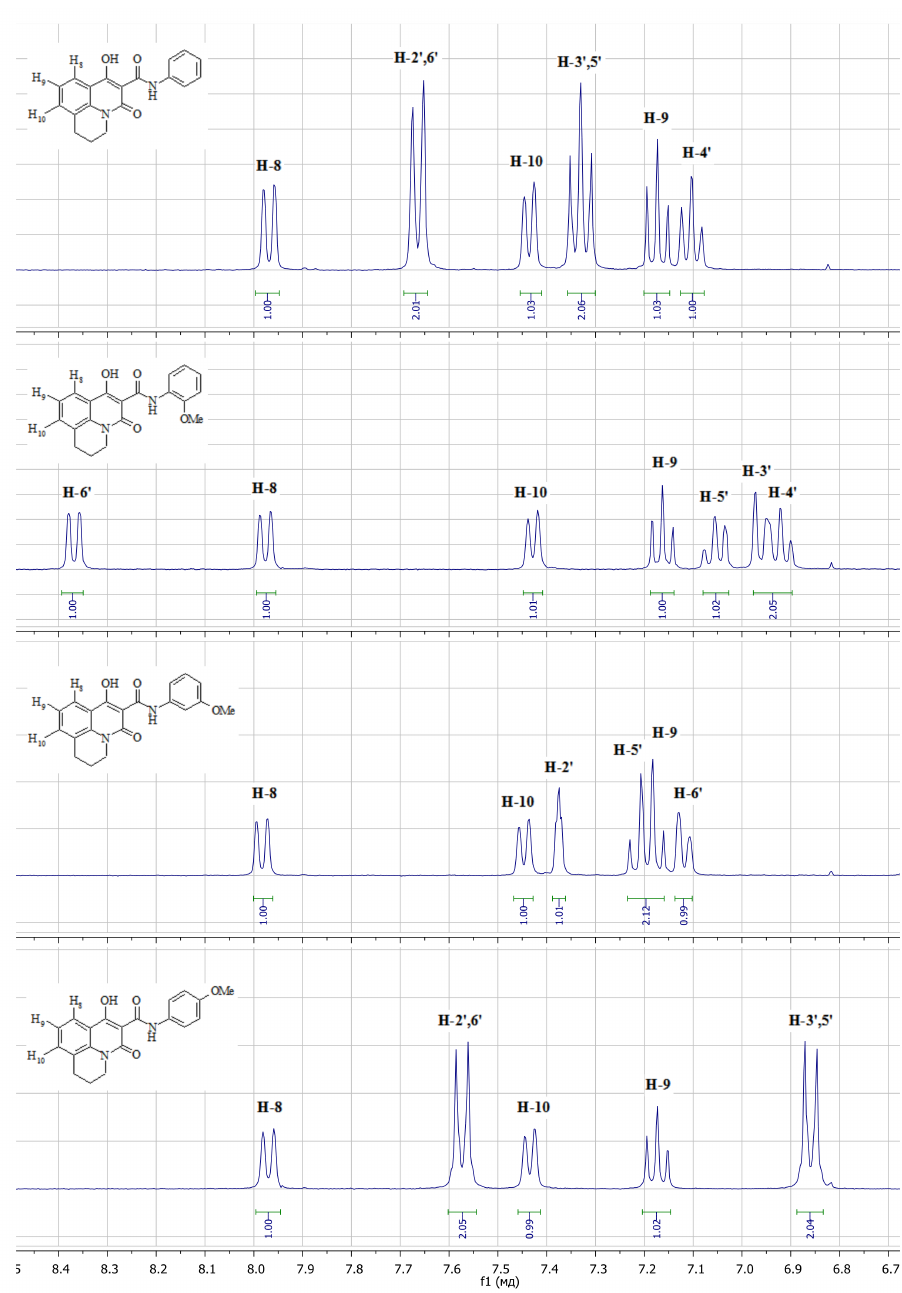
Figure 3. Fragments of 1 H-NMR spectra (the signals of aromatic protons) of the unsubstituted anilide 2a and of its monomethoxy-substituted derivatives 2e – 2g